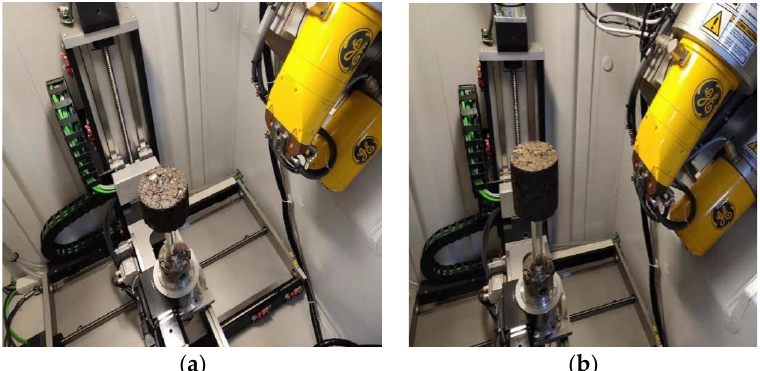
Figure 8. Industrial CT specimen scanning. ( a ) Marshall hammer sample. ( b ) Vibratory compactor sample.